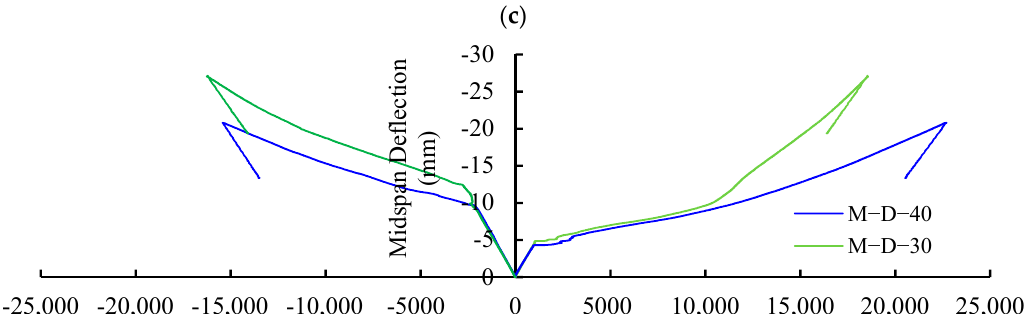
Microstarin με (at midspan with double notches on both sides of bottom flange